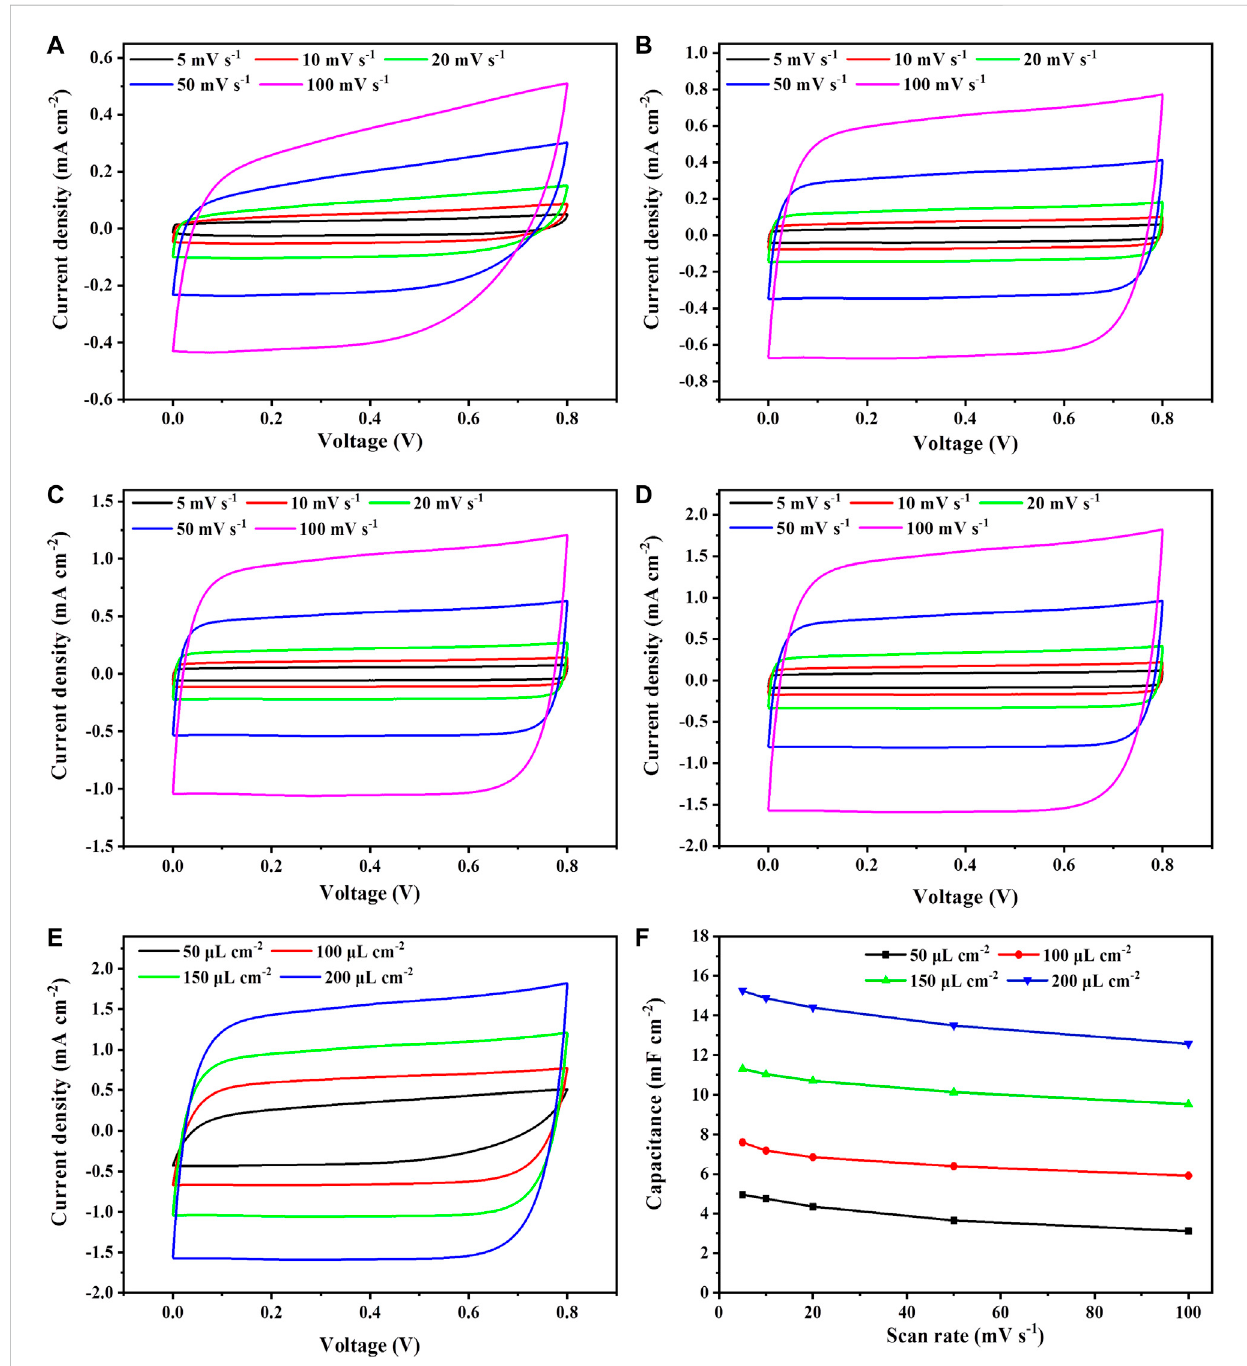
CV curves of the MSCs with different DMSO doped PEDOT:PSS solution loadings on the electrodes: (A) 50 μ L cm − 2 , (B) 100 μ L cm − 2 , (C) 150 μ L cm − 2 ,and (D) 200 μ Lcm − 2 . (E) ComparisonoftheCVcurvesoftheMSCsat100 mVs − 1 . (F) Arealspeci fi ccapacitancesoftheMSCscalculatedfrom CV